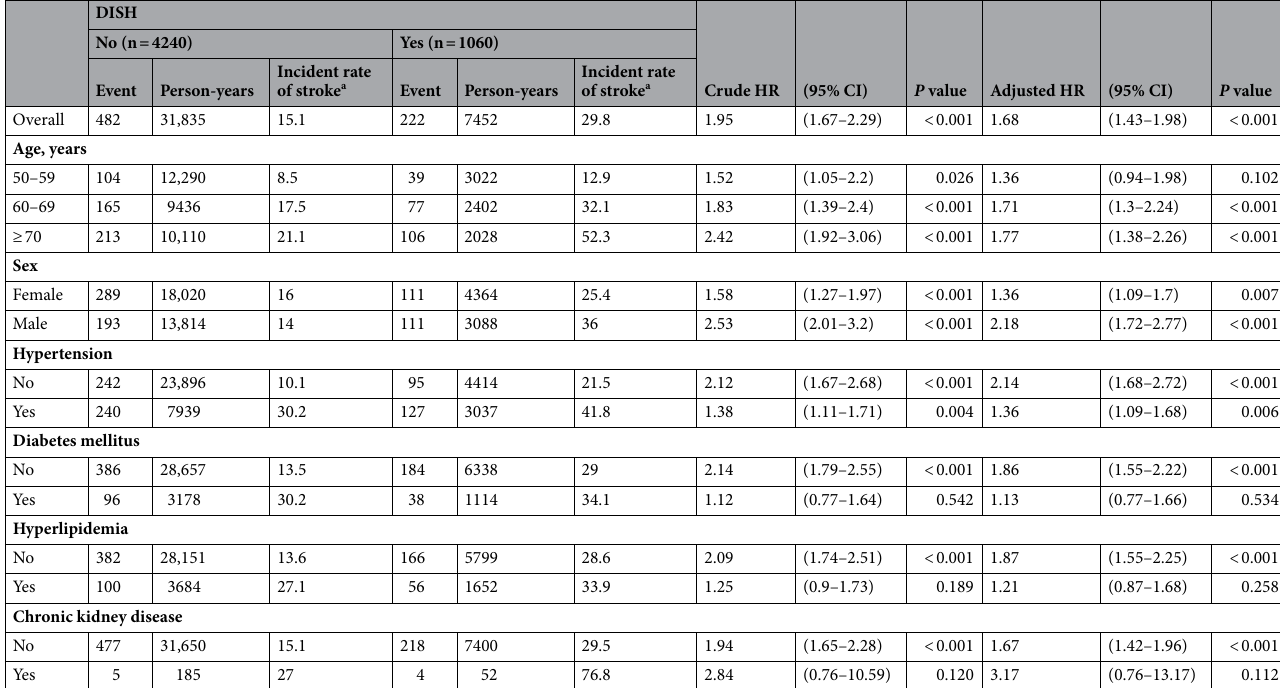
Table 3. Stratified analysis of incident rate and hazard ratio of stroke associated with DISH in Cox regression analysis. DISH diffuse idiopathic skeletal hyperostosis, CI confidence interval, HR hazard ratio. a Per 1000 person-years, * p <